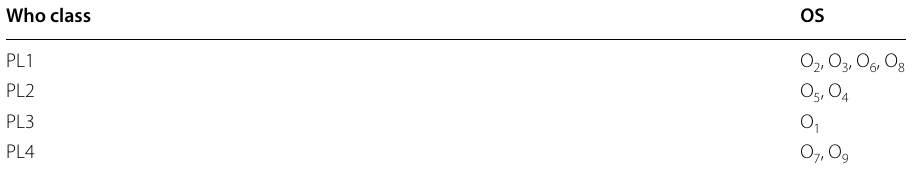
Table 4 The priority of objective of the state Who class